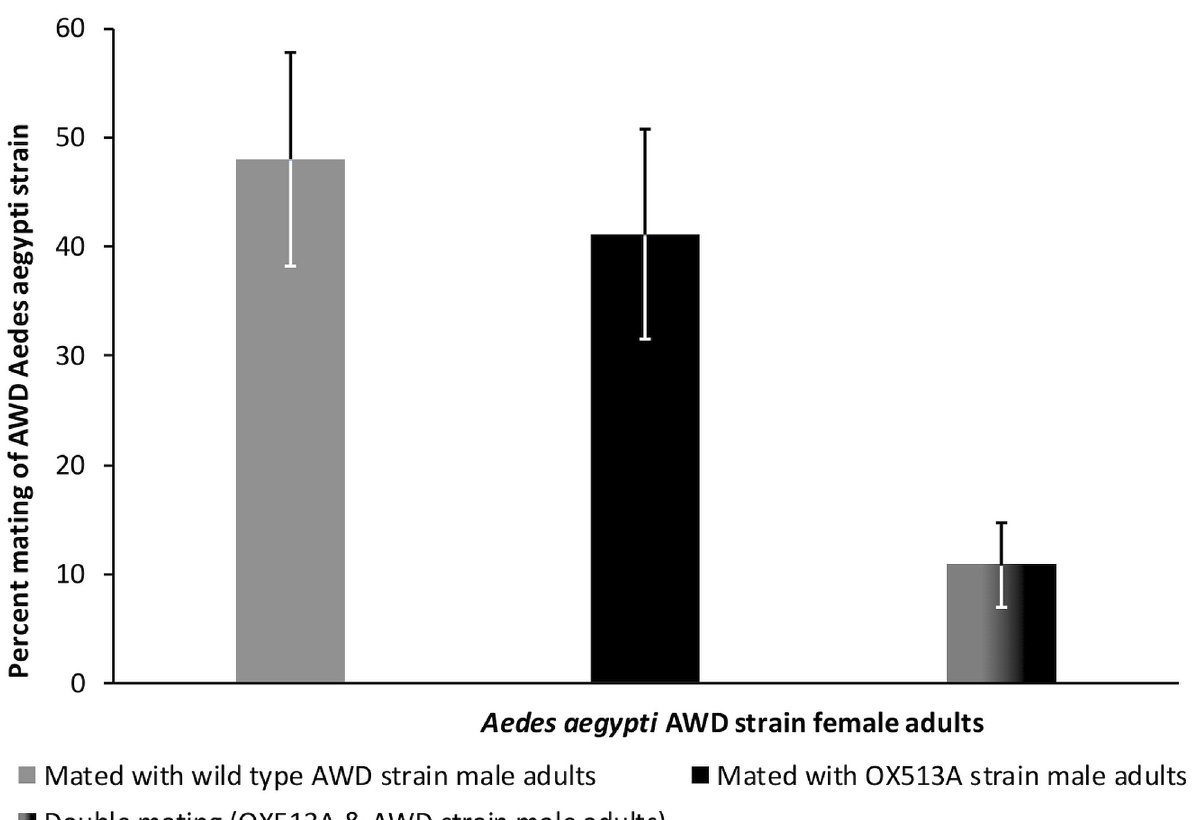
Fig 1. Percent mating of Ae. aegypti female adults with male adults of OX513A/wild type AWD Ae. aegypti strain and error bar representing standard error.